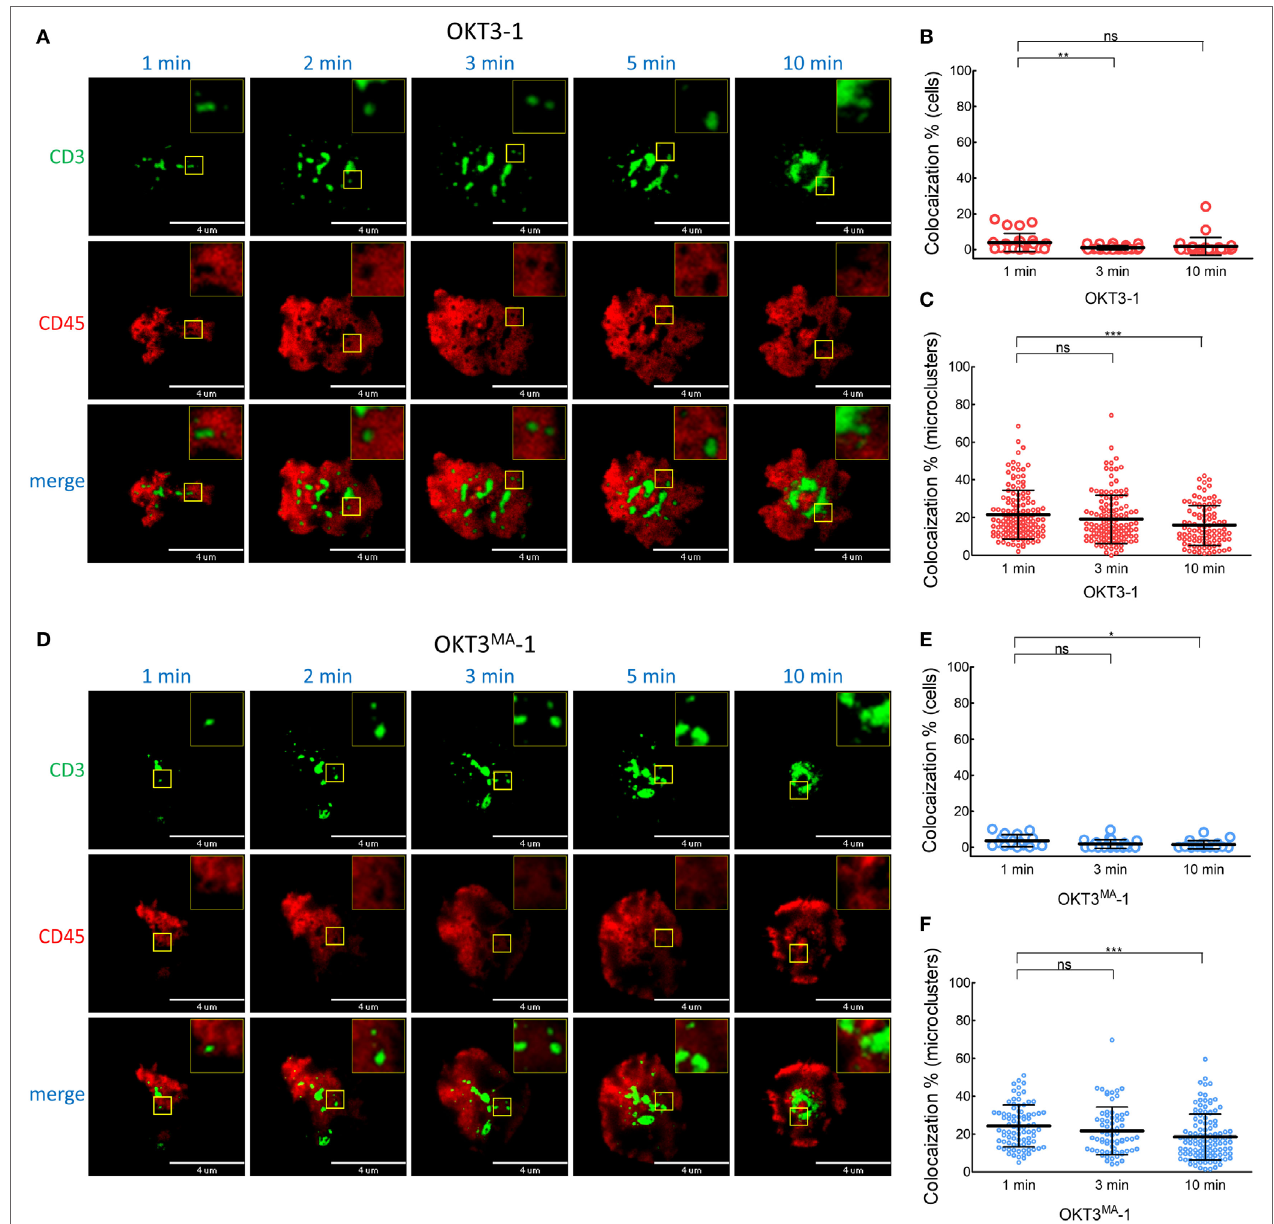
FigUre 4 | CD45 is rapidly segregated from T cell receptor complexes when T cells are activated with short ligands. (a) A representative cell was imaged for CD3 (green) and CD45 (red) by TIRF microscopy at 1, 2, 3, 5, and 10 min after contact with OKT3-1 on a planar lipid bilayer. (B) Co-localization percentage between CD3 and CD45 measured by intensity of overlapped pixels for whole Jurkat cell activated by OKT3-1 ( n = 26 cells, representative of three independent experiments). (c) Co-localization percentage between CD3 and CD45 measured by intensity of the overlapped pixels for individual microclusters obtained from Jurkat cells activated by OKT3-1 ( n = 26 cells, representative of three independent experiments). (D) A representative cell was imaged for CD3 (green) and CD45 (red) by TIRF microscopy at 1, 2, 3, 5, and 10 min after contact with OKT3 MA -BGP on a planar lipid bilayer. (e) Co-localization percentage between CD3 and CD45 measured by intensity of overlapped pixels for whole Jurkat cell activated by OKT3 MA -BGP ( n = 22 cells, representative of three independent experiments). (F) Co-localization percentage between CD3 and CD45 measured by intensity of the overlapped pixels for individual microclusters obtained from Jurkat cells activated by OKT3 MA -BGP ( n = 22 cells, representative of three independent experiments). Bars,